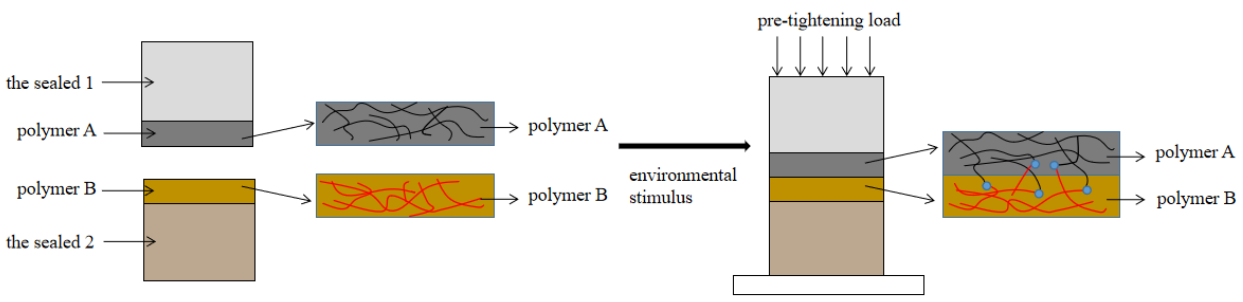
Figure 5. Schematics of implemented processes of alterable static sealing.